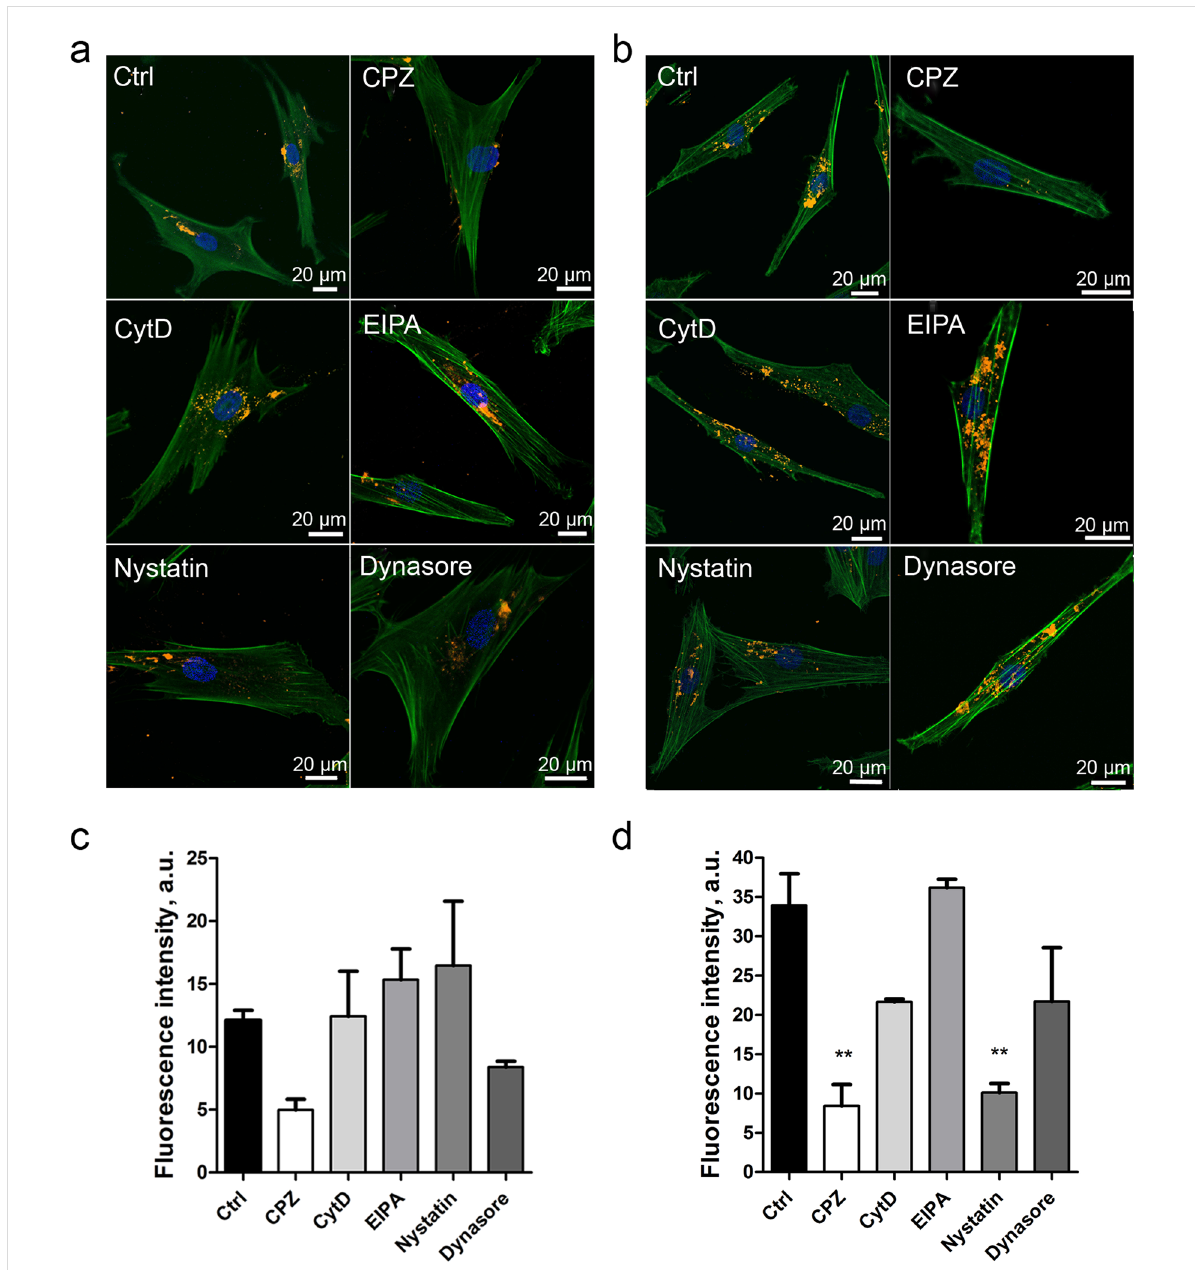
Figure 7: QD endocytic pathway in MSCs. QD uptake pathway in MSCs labelled with QDs in complete medium (a) or in serum-free medium (b). Uptake pathways were blocked using the endocytosis inhibitors CPZ, CytD, EIPA, nystatin and dynasore. Three overlaid channels represent Hoechst (blue), Phalloidin Alexa Fluor488 (green), carboxyl QD655 (yellow). Representative data are shown. QD fluorescence signal was quantified in com- plete (c) and in serum-free medium (d) cultivated MSCs. Statistical significance shown for the respective sample in comparison to control (Ctrl) sam- ple; **p-value <